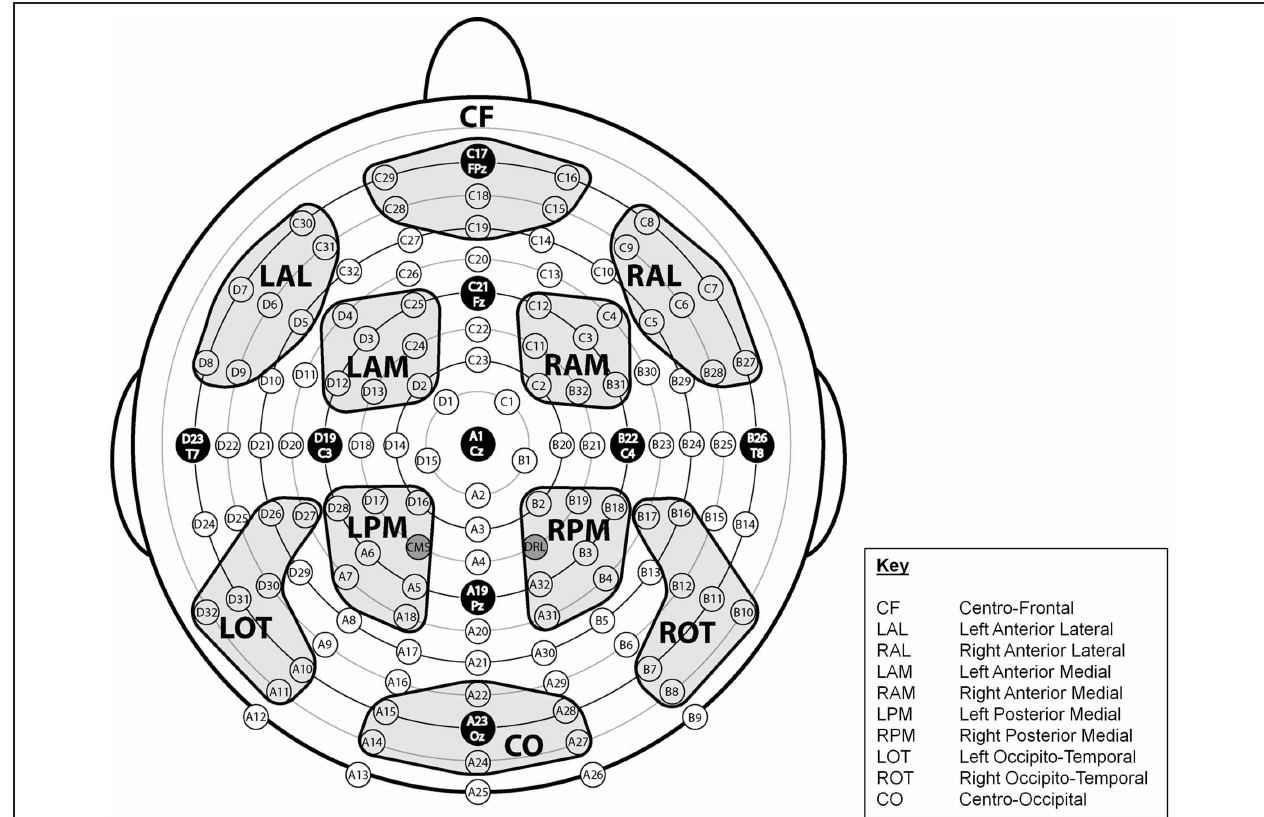
FIGURE 2 | Montage illustrating the location of 128 electrode sites and the 10 designated regions of interest (ROIs).